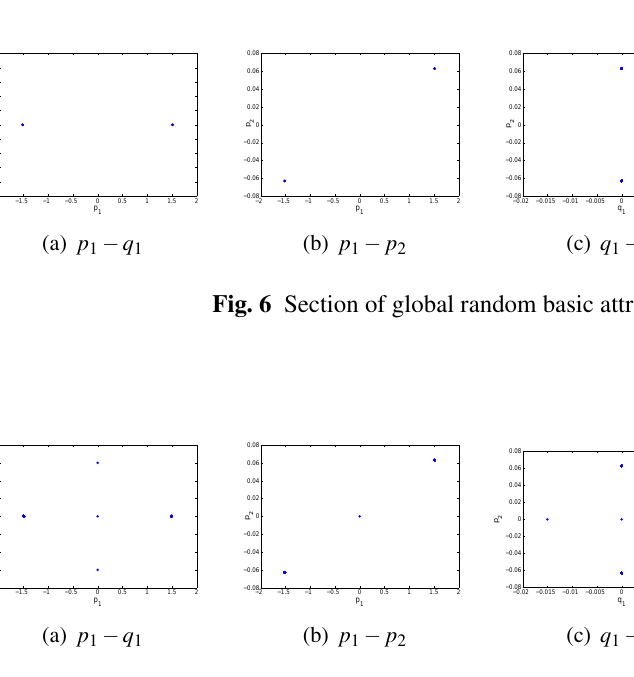
Fig. 7 Section of global random point attractors for ϕ NGM 3 with case III